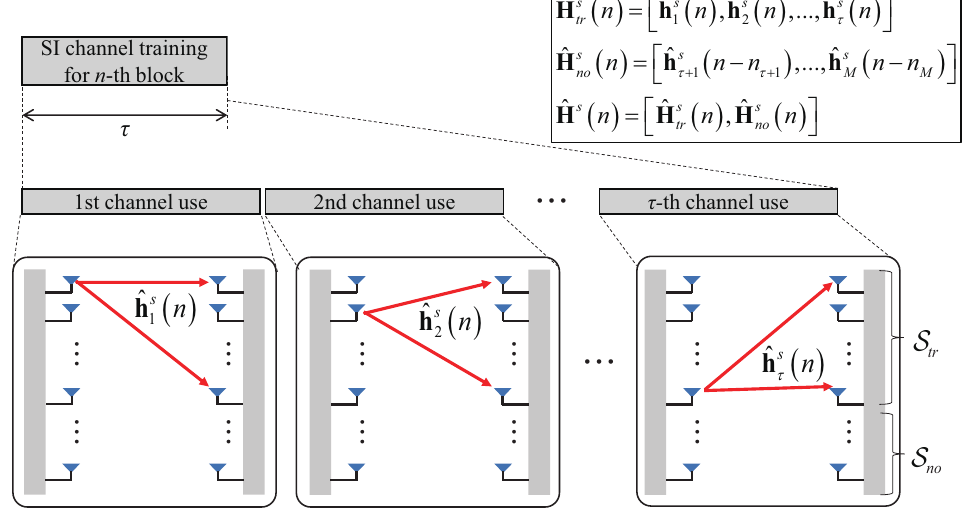
Figure 3. An example of partial SI channel training with limited training length, assuming τ = L for